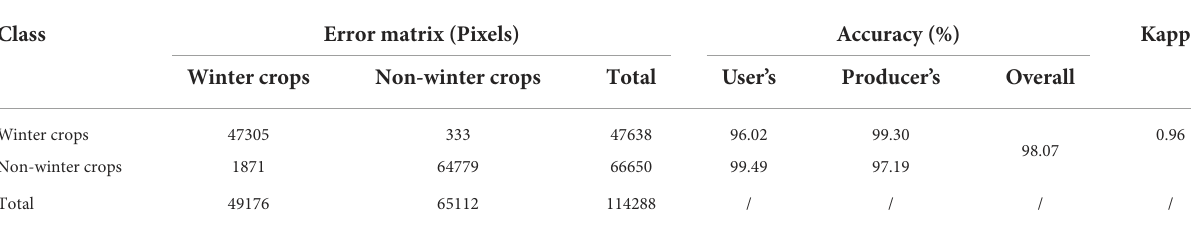
TABLE 1 Results of accuracy validation for the winter